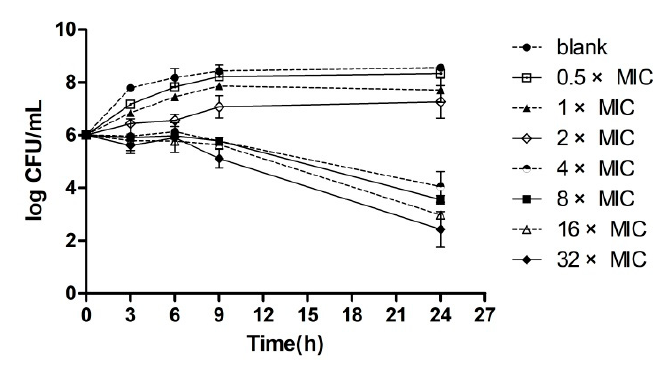
Figure 2. Time-kill curves for MRSA ATCC 43300 with different concentrations of amphenmulin.